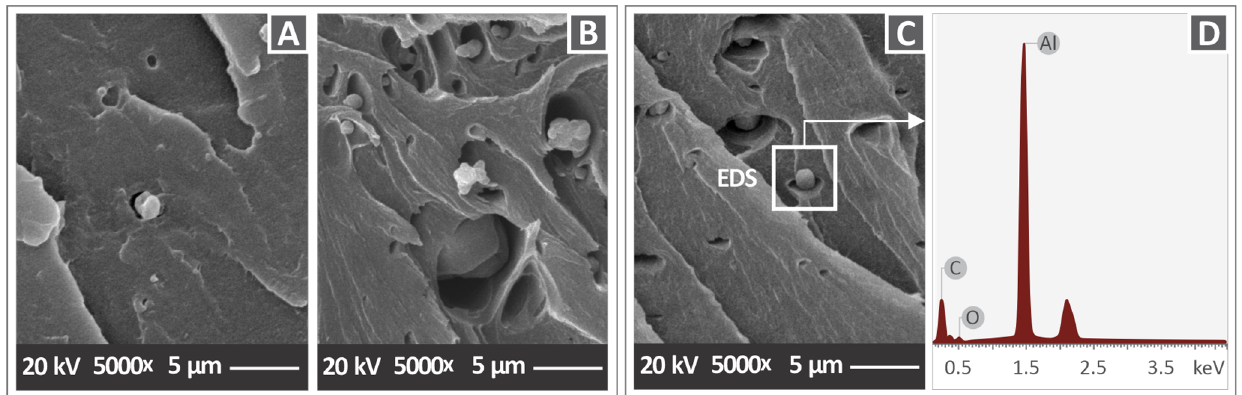
Figure 16. SEM images of fracture surface with a magnification of 5000× magnification of ( A ) PC/AlN 1 wt.% ( B ) PC/AlN 3 wt.%, ( C ) PC/AlN 6 wt.%, and ( D ) EDS analysis of PC/AlN 6 wt.% nanocomposite, obtained on the agglomeration, as illustrated in ( C ).